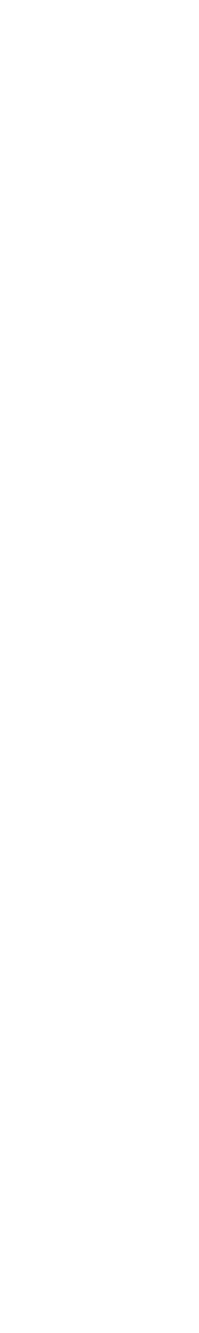
TABLE 6 | Sustained intervals of R/MM status and the real-time R/MM status at each follow-up in the sensitivity analysis cohort. Sustained Non- R/MM at 3 months ( n = 102)